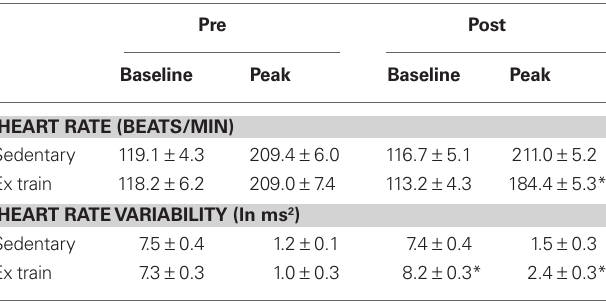
Table 1 | The heart rate and heart rate variability responses to submaximal